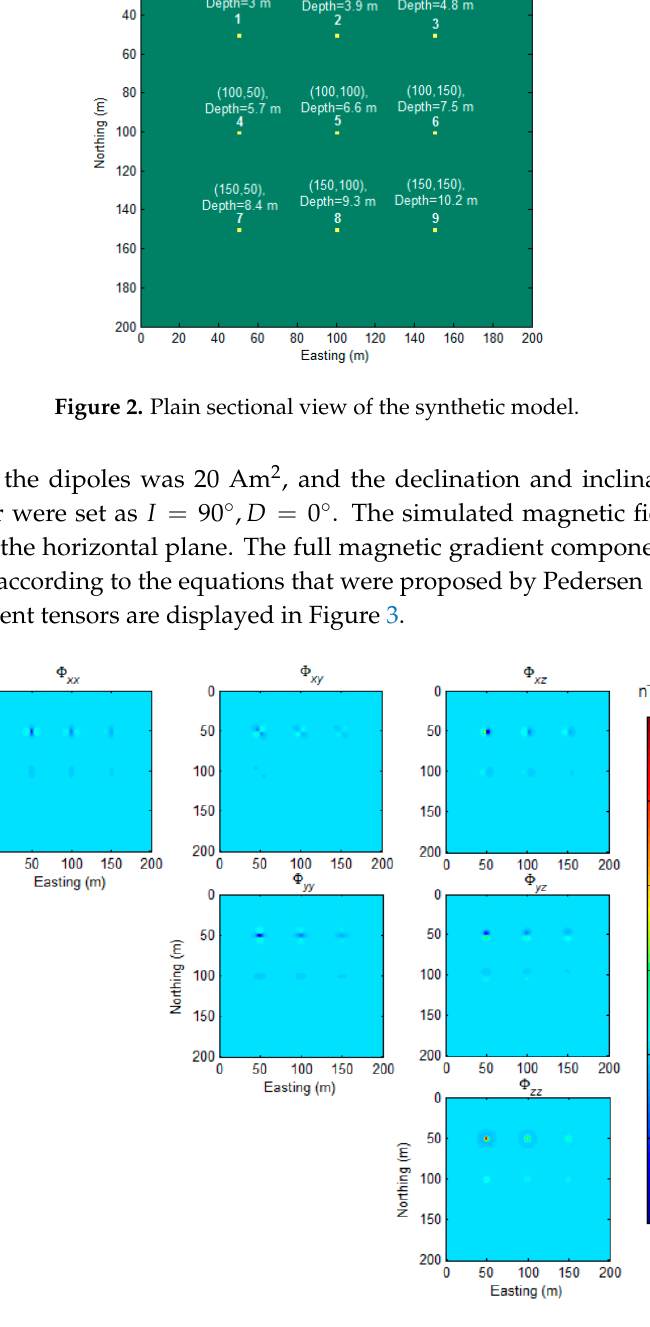
Figure 3. The simulated magnetic gradient tensor data.